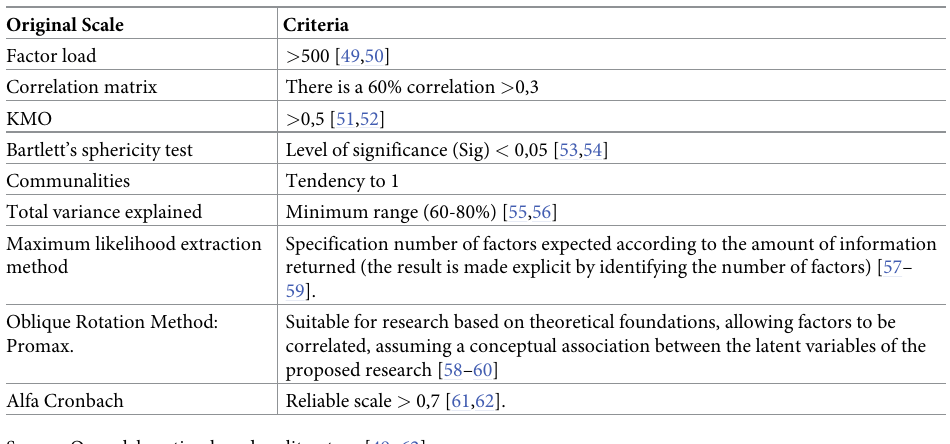
Table 4. Criteria and tests in the factor analysis.